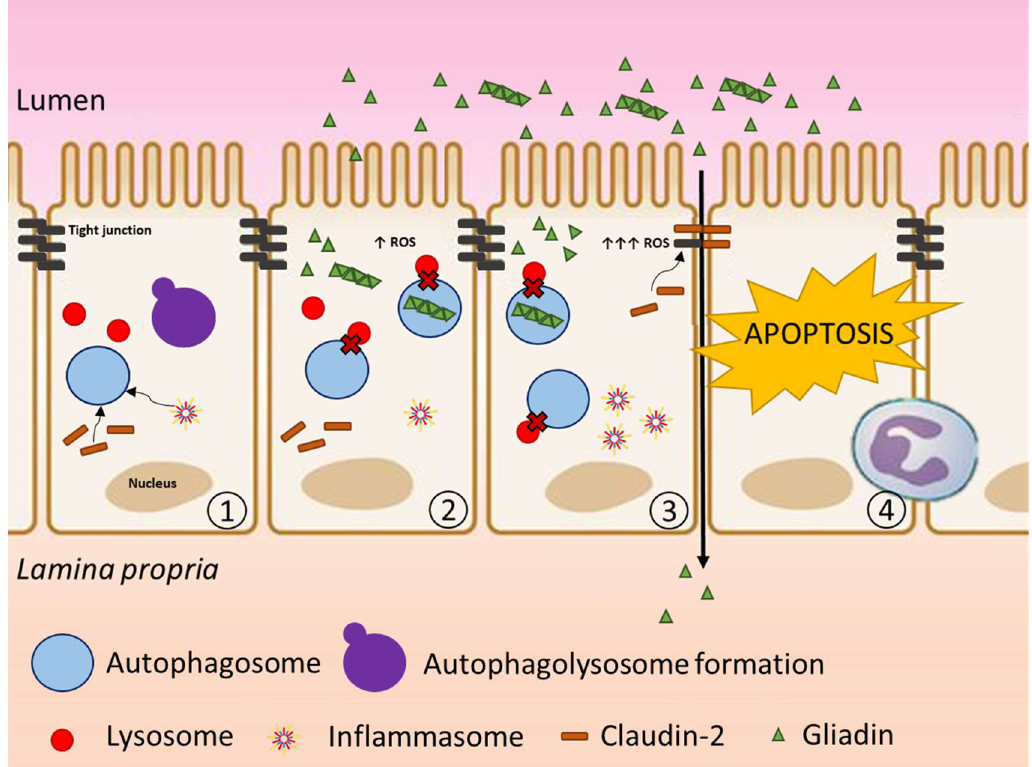
Figure 15. Interpretative model of autophagy involvement in CD. (1) Normal enterocyte: autophagy flux is active and is involved in the control of the cellular homeostasis, e.g., degradation of claudin-2 and inflammasome negative regulation. (2) Gliadin peptides enter in the intestinal epithelial cell generating ROS and triggering an autophagy response. Autophagy blockage occurs as a consequence of the stress persistence. (3) Because of the autophagy blockage, oxidative stress increased thus contributing to a dysregulated inflammatory response caused by the lack of degradation inflammasomes. Tight junctions (TJs) formation is compromised leading to an increase in paracellular permeability. (4) Inflammation and intraepithelial lymphocytes (IELs) activation lead to apoptosis of the intestinal epithelial cells.